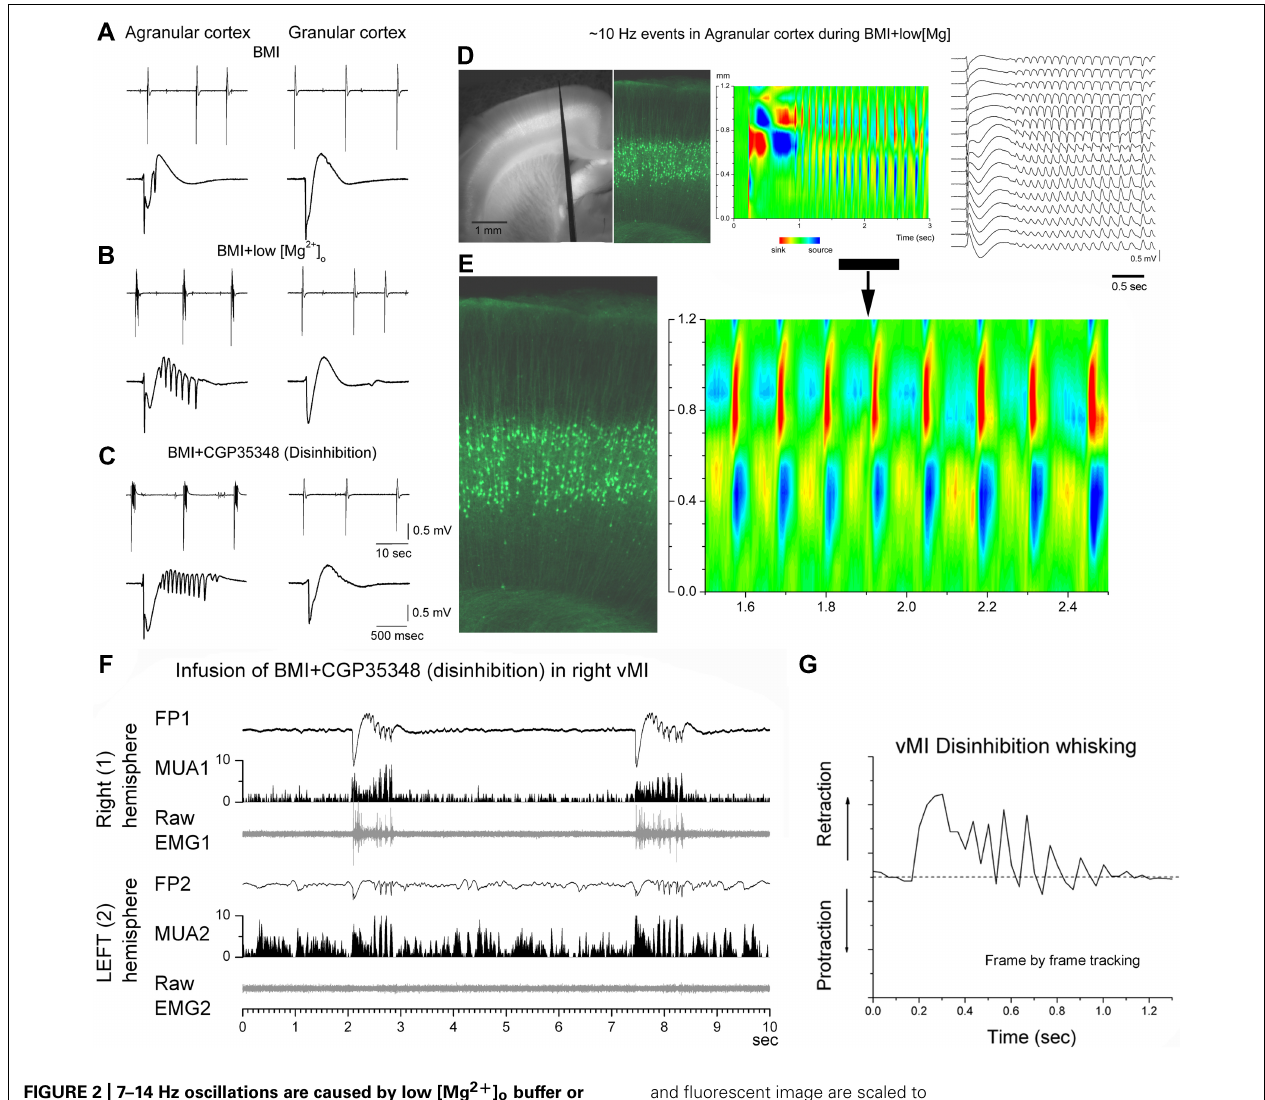
and fluorescent image are scaled to match the cortical layers location with the location of the current flow (Castro-Alamancos andTawara-Hirata, 2007). (E) Close-up of the 7–14 Hz event shown in (D) . (F) 7–14 Hz oscillations caused by disinhibition in the whisker motor cortex (vMI) of a freely behaving rat. Bilateral field potential (FP) and multi-unit (MUA) activity recorded from the vMI during